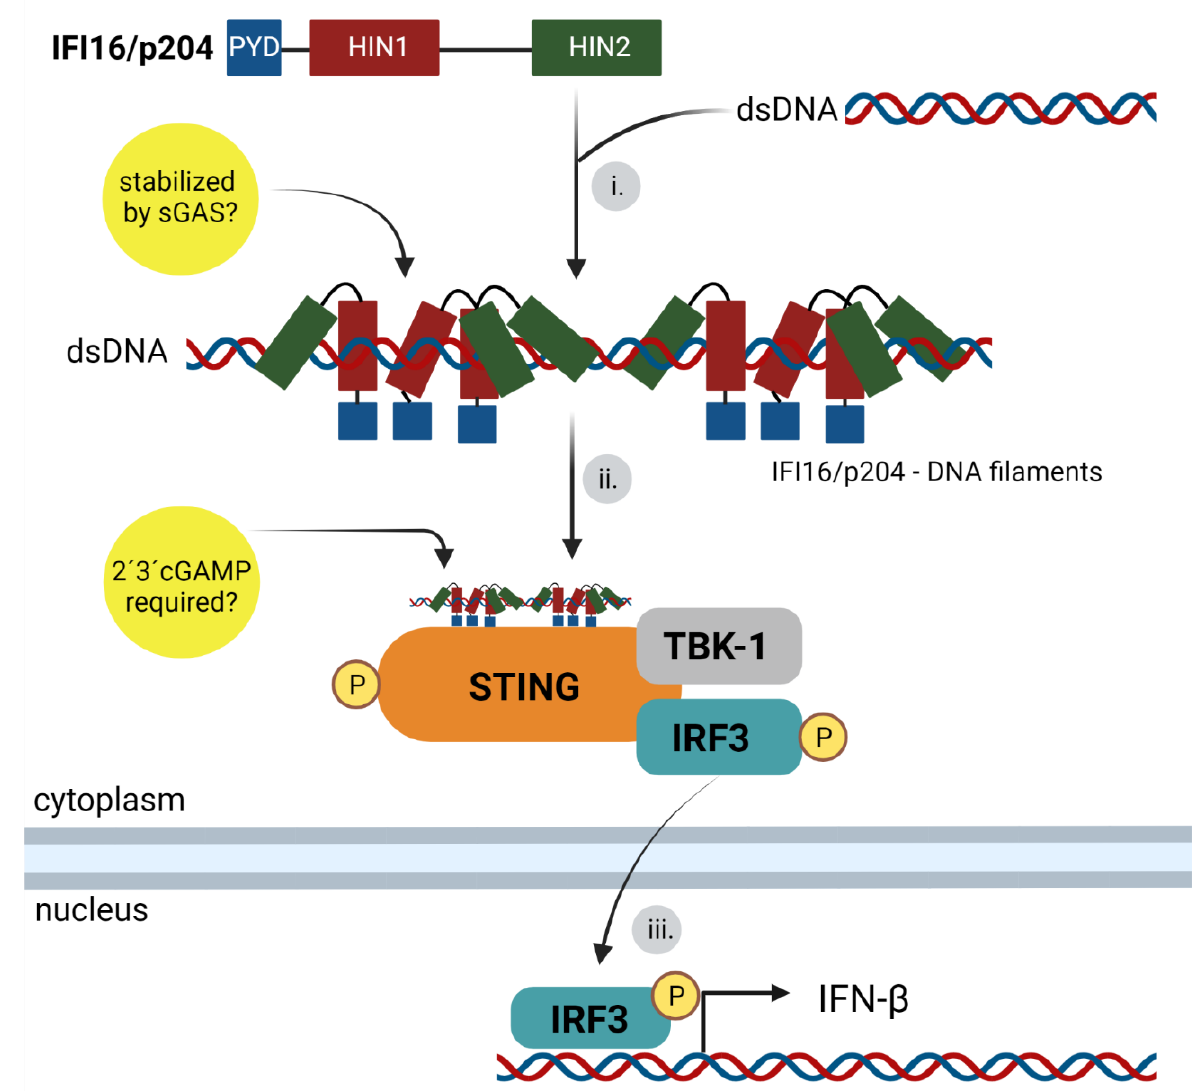
Figure 5. IFI16 or p204/Ifi-204 interferon signaling pathway. IFI16 or p204/Ifi-204 recognizes dsDNA via HIN domains, which induce HIN domains’ oligomerization, leading to the clustering of PYD domains. Next, the IFI16-DNA complexes travel to STING localized in perinuclear areas and then TBK1 and IRF3 are recruited. STING and IRF3 are phosphorylated by TBK1. Phosphorylated IRF3 translocates to the nucleus and activates the production of IFN β . The possible overlapping of the cGAS pathway with the IFI16-STING pathway is shown (the stabilization of IFI16 by cGAS or the requirement of 2′ - 3′ cGAMP for IFI16 STING stimulation). Created with BioRender.com.